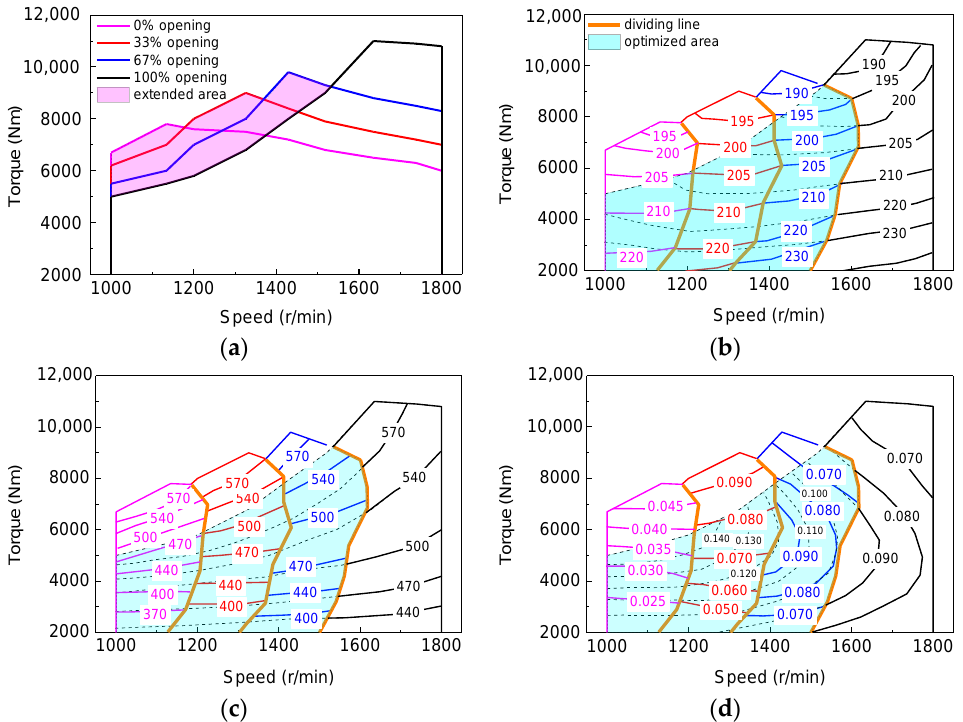
Figure 8. Matching characteristics of the VGT system. ( a ) extended area. ( b ) contour of the BSFC. ( c ) contour of the exhaust temperature. ( d ) contour of the smoke opacity.